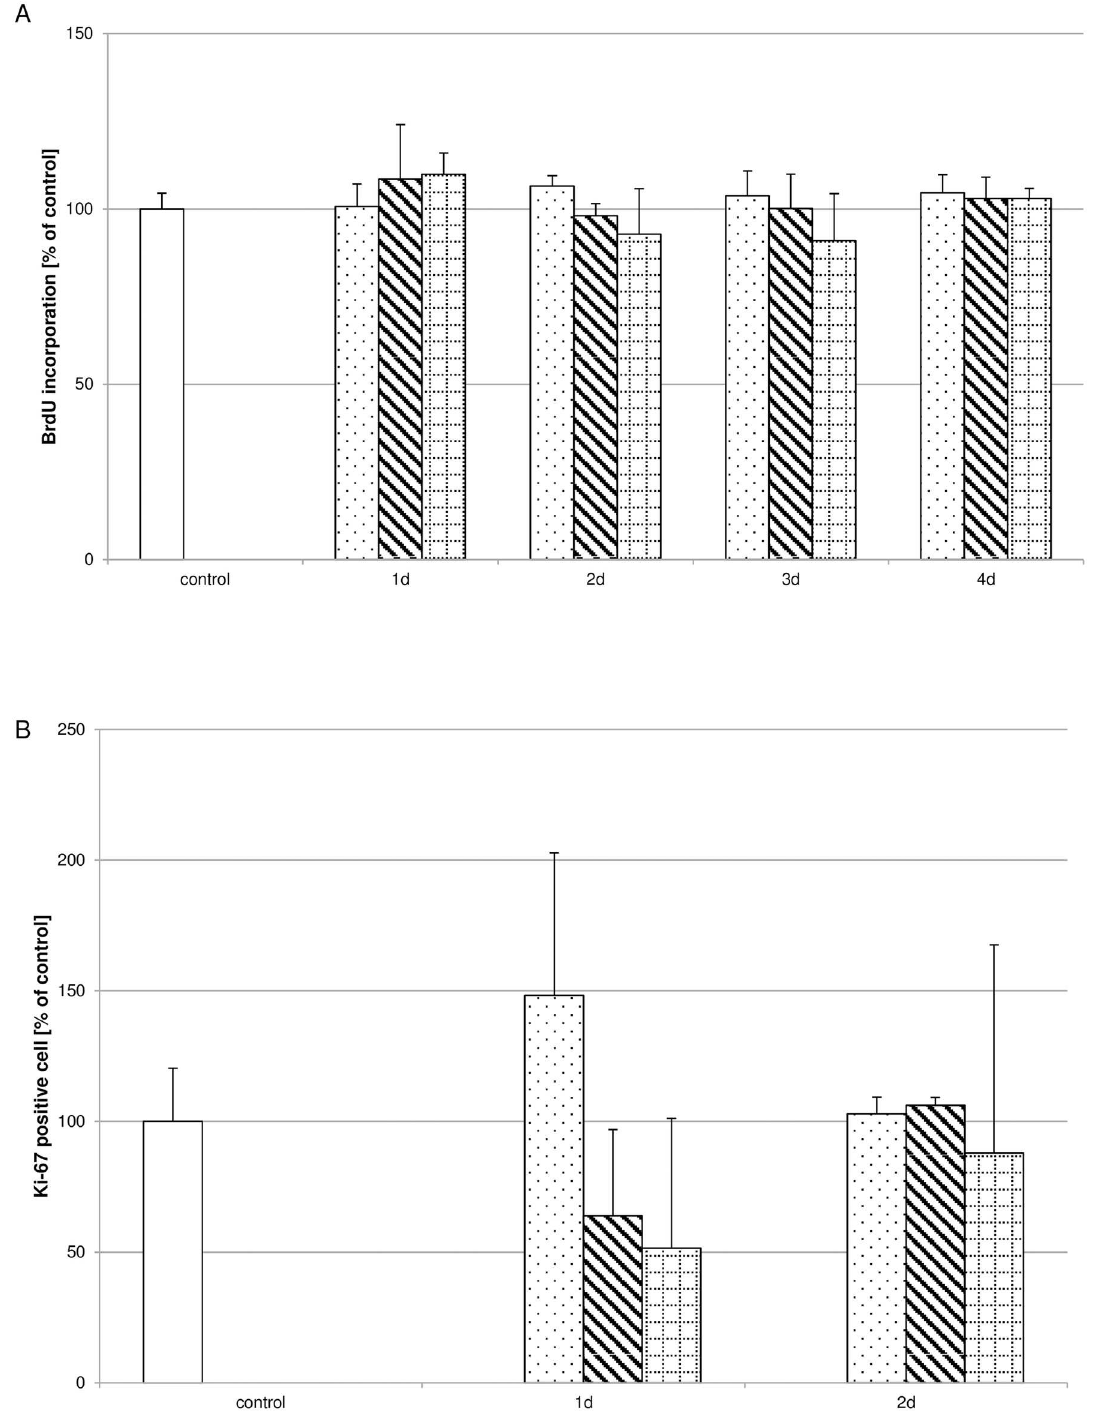
Fig 3. Influence of Biodentine ® suspensions on proliferative processes. Neitherthe incorporation of BrdU (A; N = 270) nor the number of Ki-67 positive cells (B) was significantly influencedby the Biodentine ® suspensions of low (dotted bar), moderate(striped bar) or high (brickedbar) Biodentine ® concentrations in comparison to the control (white bar). The data displayedare representativeof three independentexperiments (BrdU) or two independentexperiments (Ki-67) performed with comparableresults. Averageabsorbancevalues (mean ± SD) from n = 6 replicates per experimental conditioncalculated for the BrdU assay and the percentalamount of Ki67-positive cells correlated to the control are shown.